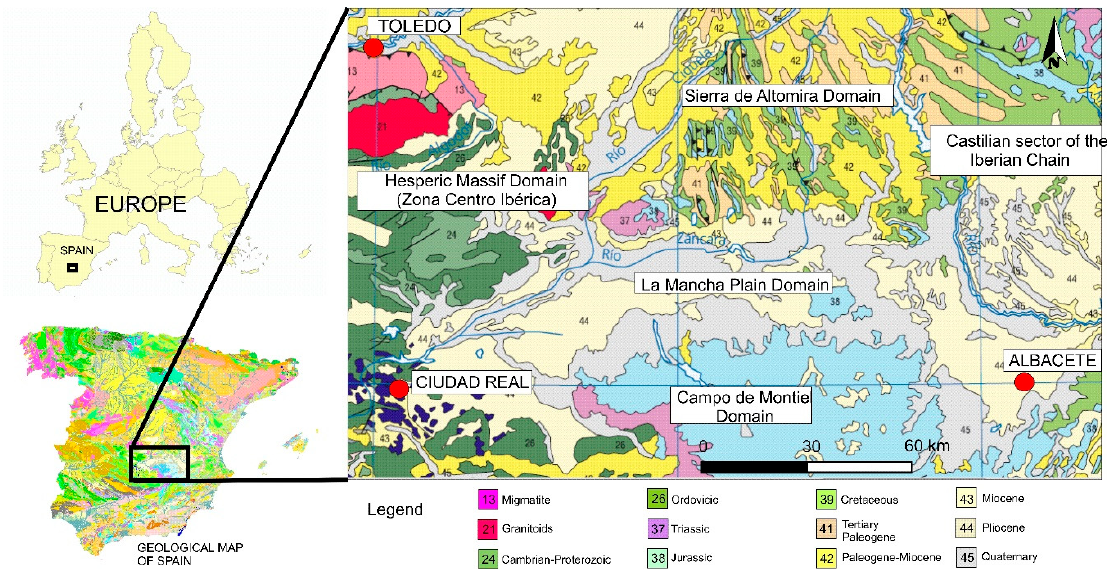
Figure 1. Location of the study area according to geological domains.